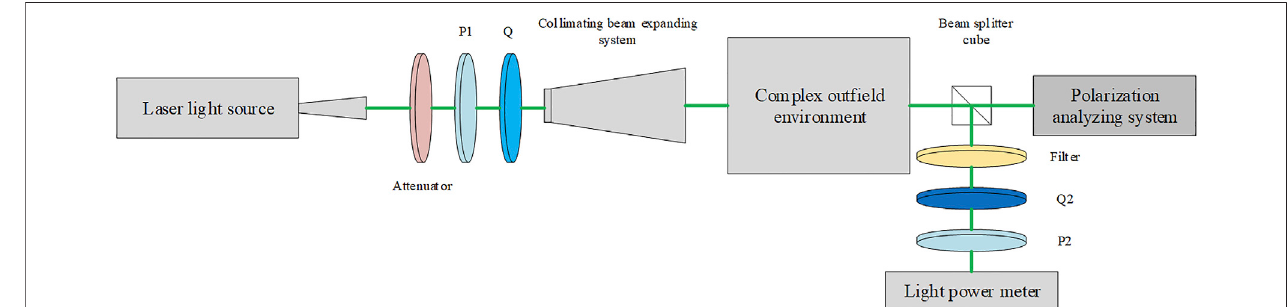
FIGURE 5 | Experimental scheme.